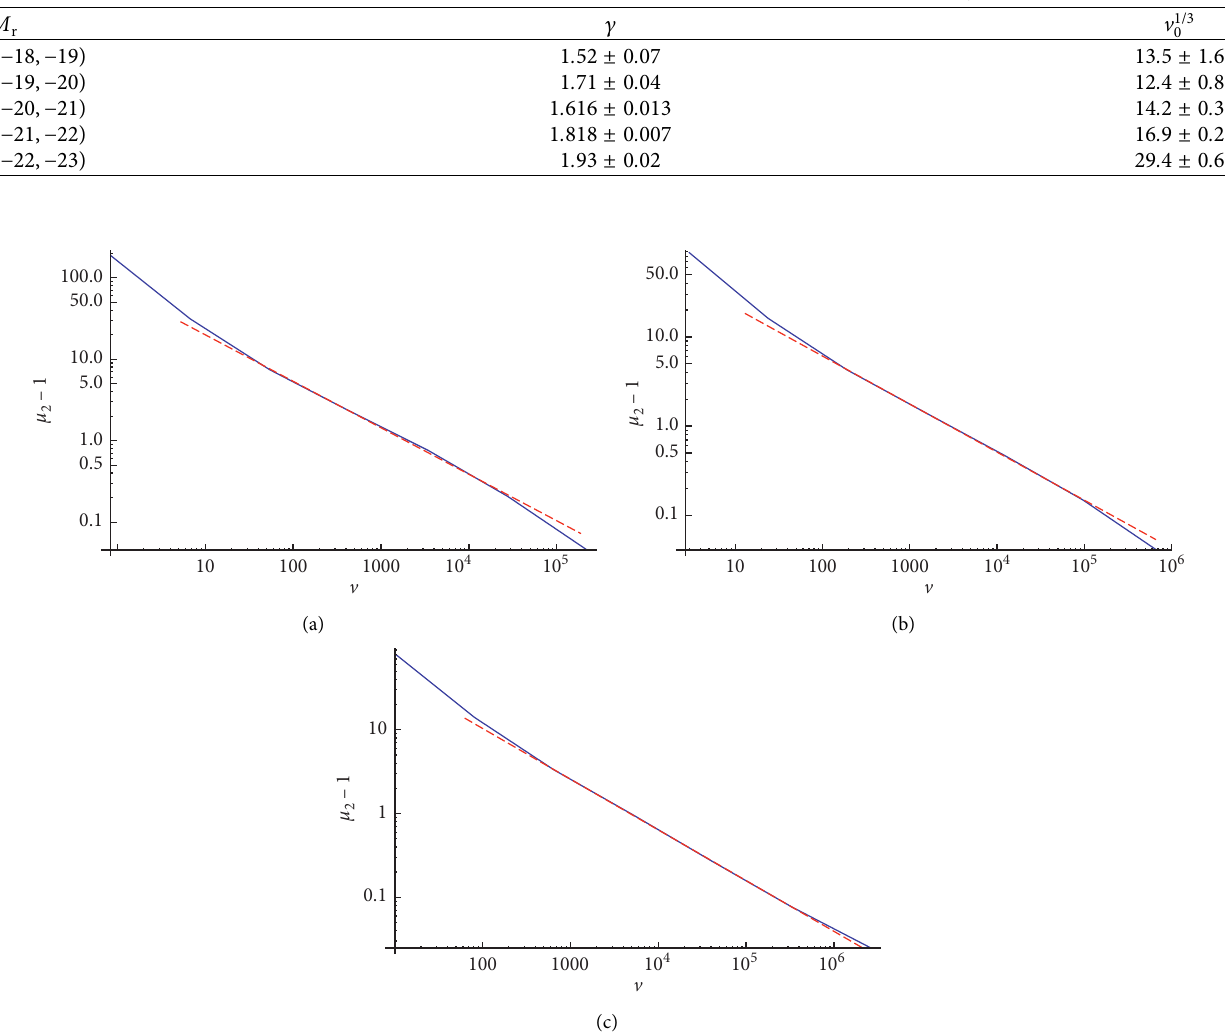
Table 2: Results for scaling in the five volume-limited samples with higher mass density ( v 1/3